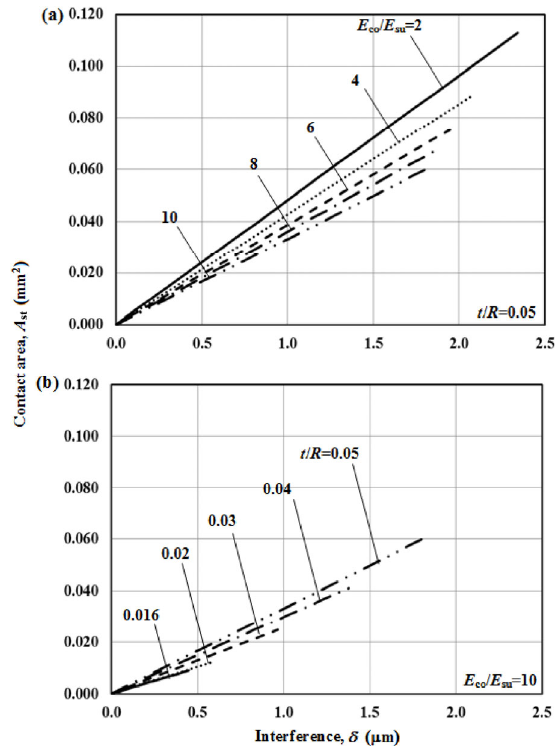
Fig. 12 Typical results for the contact area A st vs. the interference  (  y_su =  y_co = 0.001,  = 0.32): (a) t / R = 0.05 and (b) E co / E su =